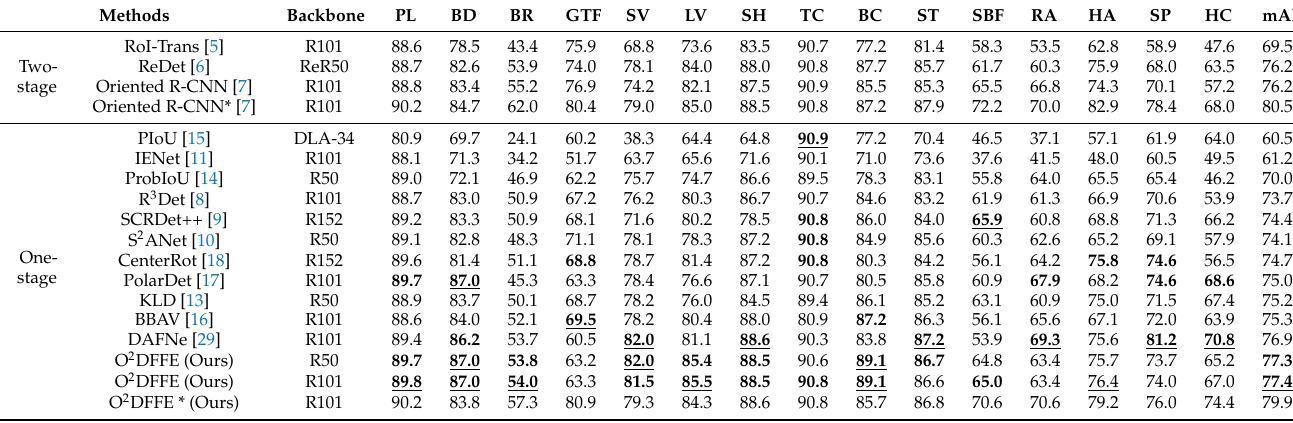
Table 1. Evaluation results on DOTA1.0 datasets. R50 denotes ResNet50. R101 denotes ResNet101. R152 denotes ResNet152. H104 denotes Hourglass104. ReR50 denotes ReResNet50. * denotes multiscale training and multiscale testing. Bold and underlined data denotes best performance. Bold data denotes second best